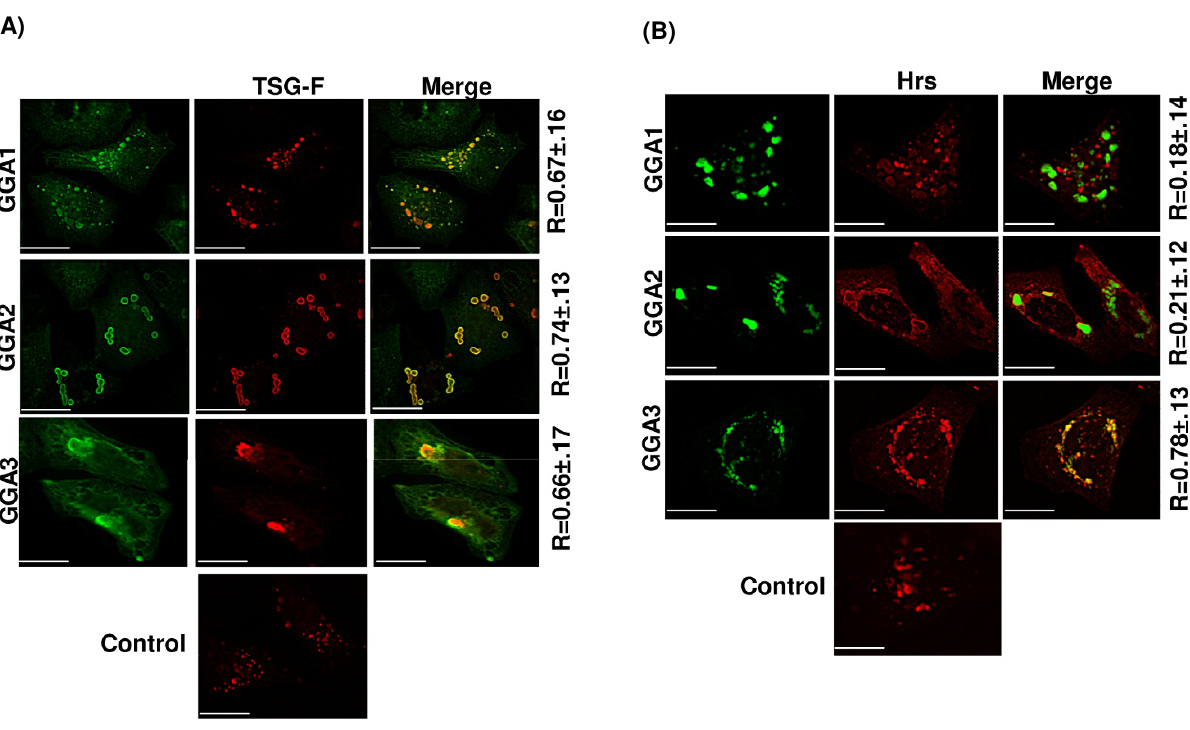
microscopy. Numbers represent mean colocalization (R value) ± SD from 8-10 cells. Size bar represents 15 (cid:80)